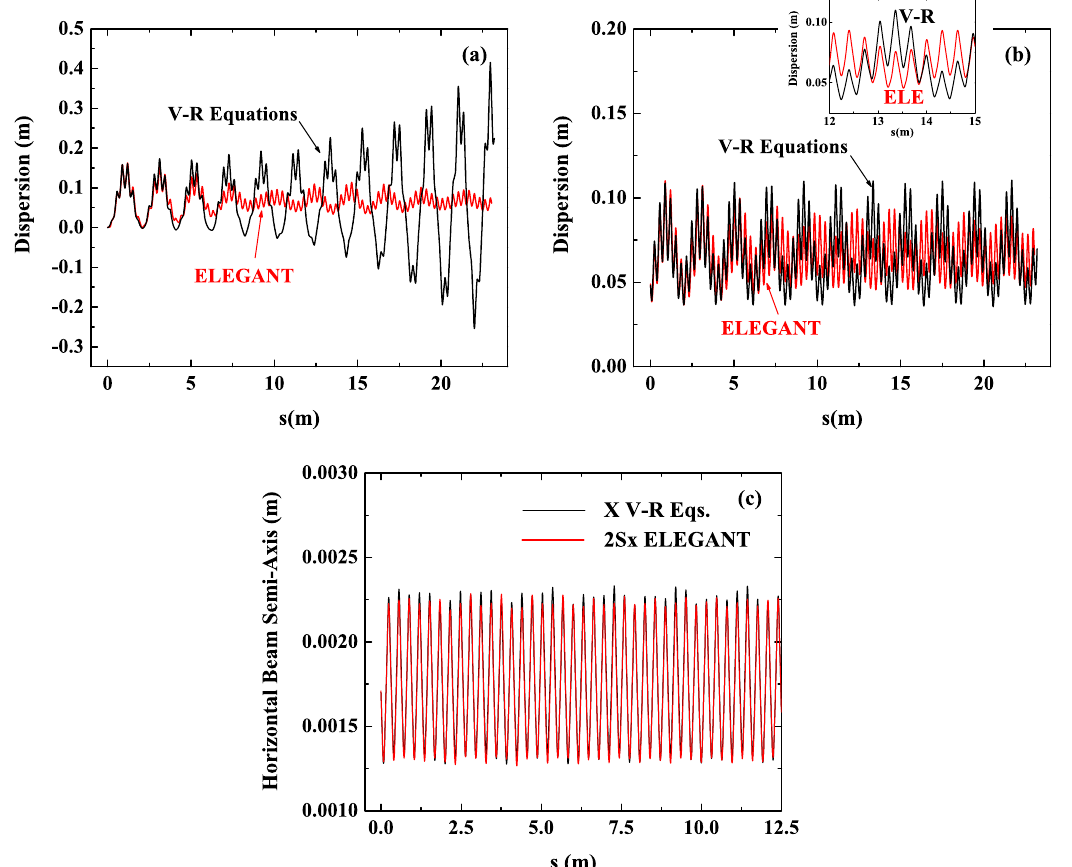
FIG. 3. Comparison of results from ELEGANT and V-R equations for the dispersion functions at 0.6 mA, (cid:1) ¼ 0 : 002 in UMER (two turns) for (a) mismatched, and (b) near-matched conditions. The horizontal beam envelopes over one turn for near-matched conditions are shown in (c). The dispersion function from ELEGANT in (b) appears to be shifting ahead of the V-R curve, but the inset indicates that this is not the